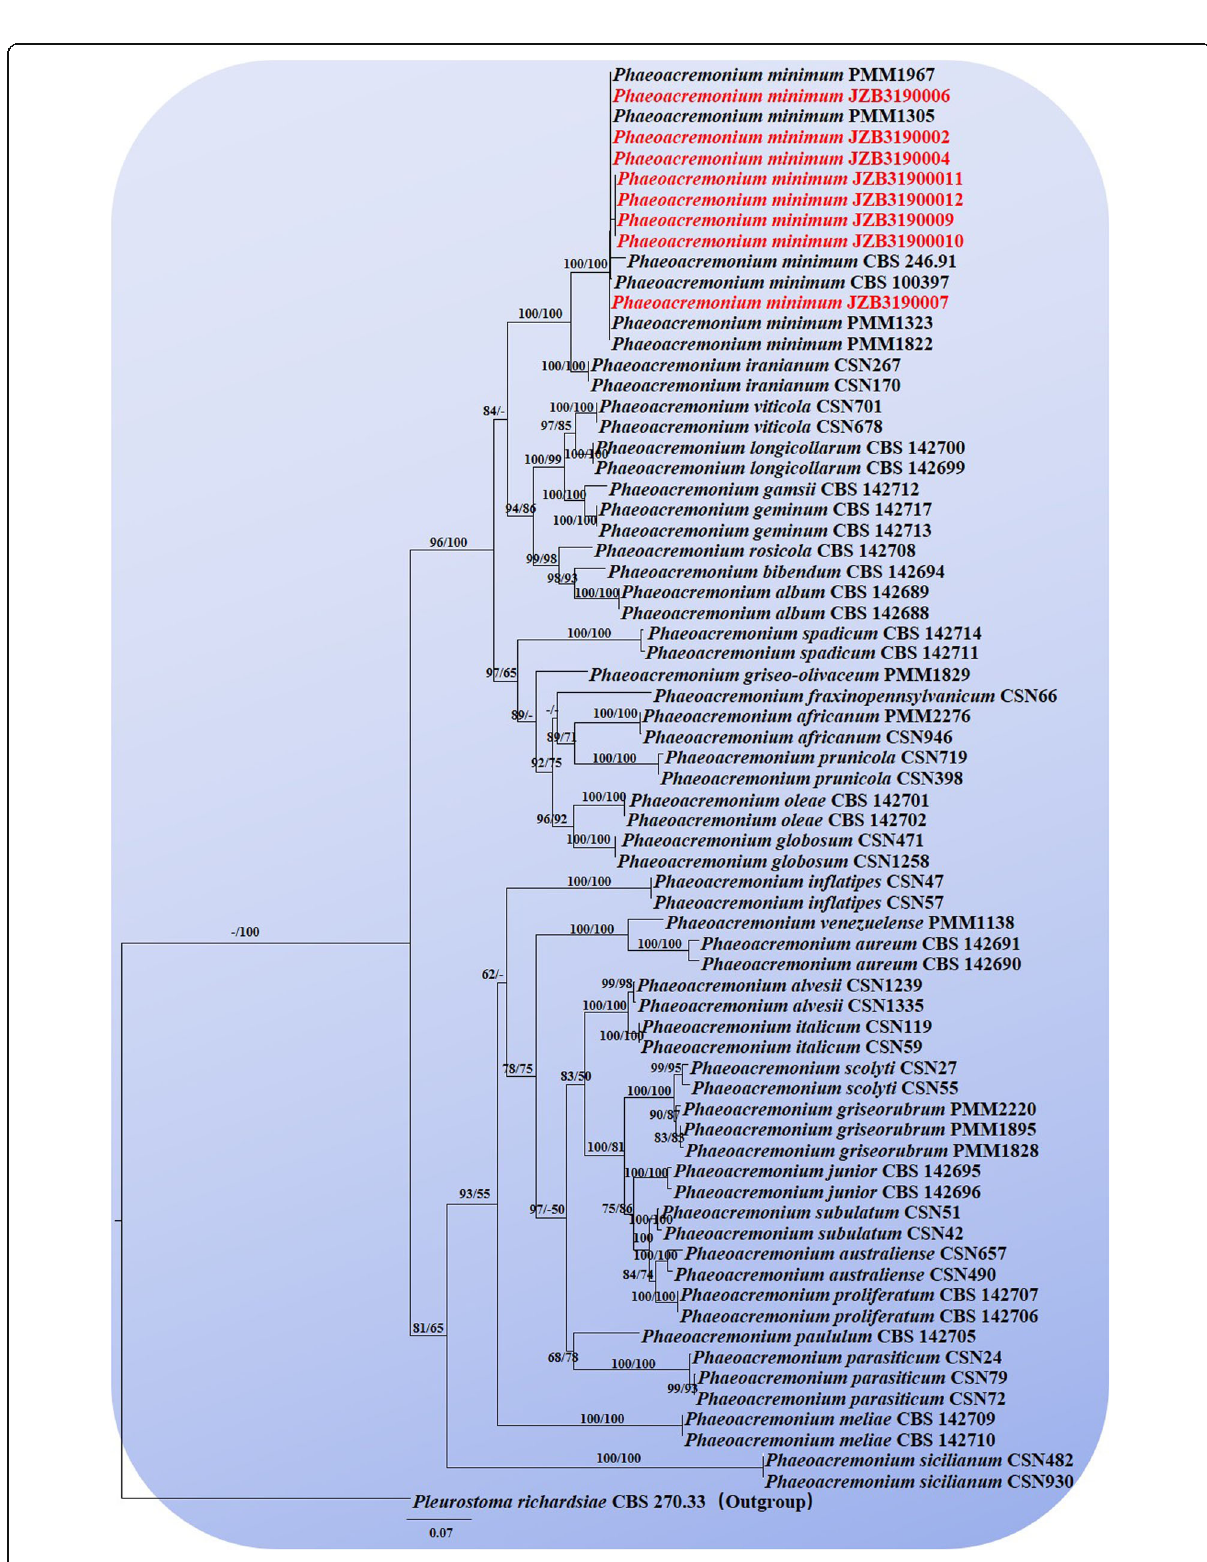
Fig. 4 RAxML tree obtained from phylogenetic analysis of combined genes of actin and beta-tubulin. Maximum likelihood and parsimony bootstrap values are shown in nodes (the values lower than 50% are not given). The scale bar shows 0.07 changes. The tree is rooted in Pleurostoma richardsiae (CBS